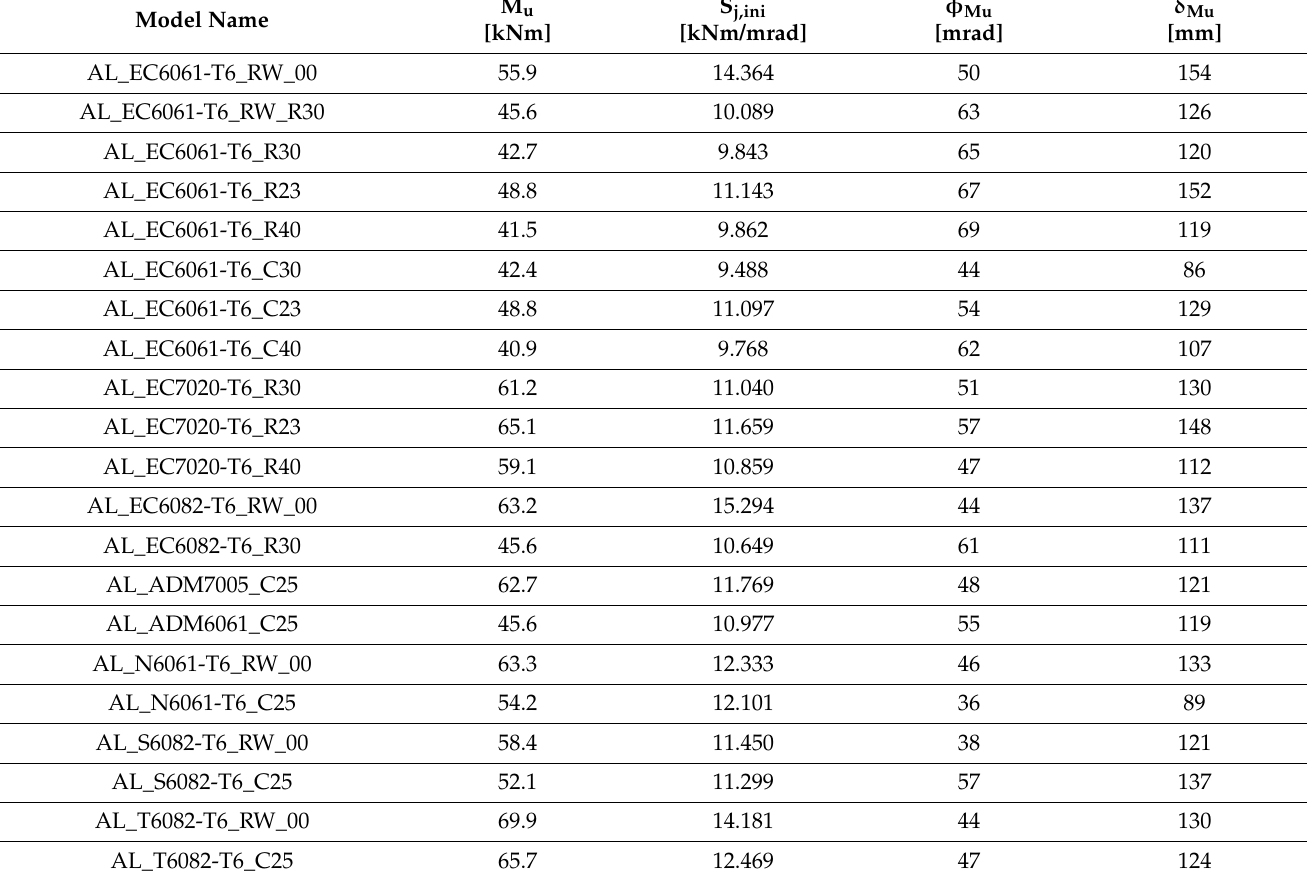
Table 4. Numerical results for joint ultimate resistance, initial stiffness, and ductility.